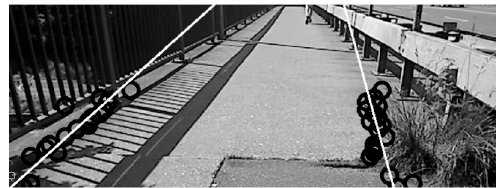
Figure 10. Road borders with low confidence value.